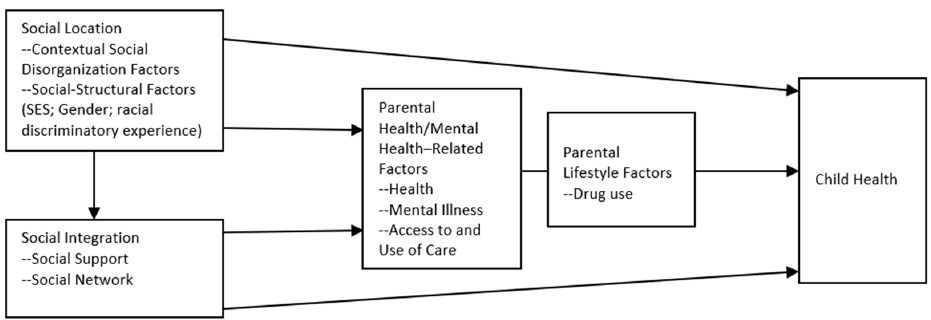
Figure 1. The multiple disadvantage model explaining Asian child health.